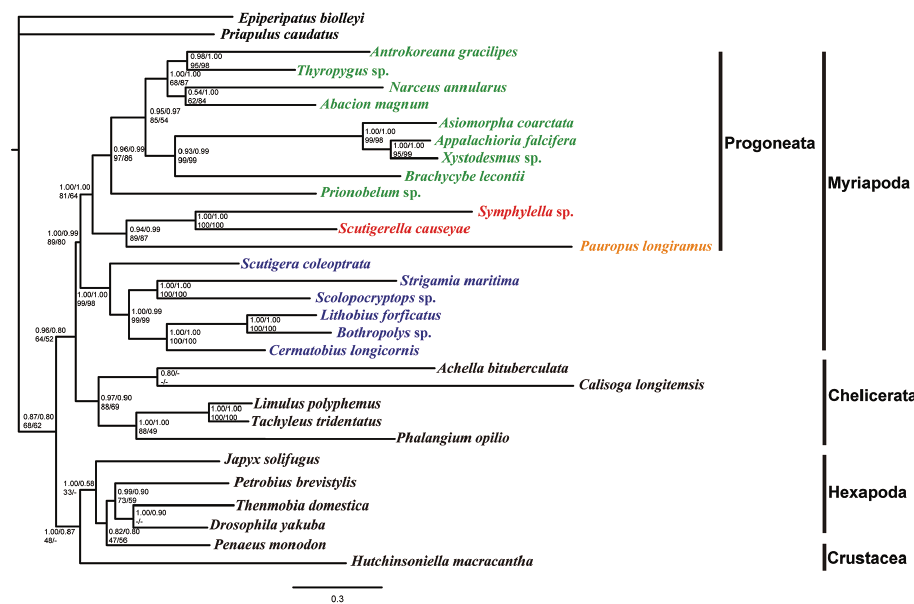
Figure 6. Phylogenetic tree of the Arthropoda, including Myriapoda, Hexpoda, Crustacea and Cheli- cerata and outgroups reconstructed based on protein-coding genes from mtDNA genomes. Each group of four numbers indicates node confidence values (from top left): Bayesian posterior probabilities in per- cent (BPP) in amino acid and nucleotide datasets; maximum likelihood bootstrapping values (MLBP) in amino acid and nucleotide